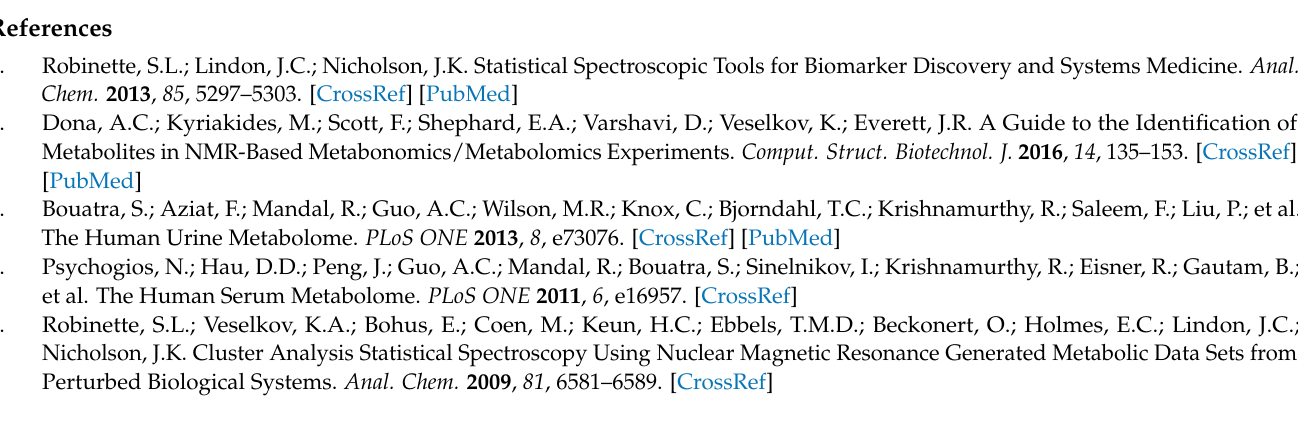
Figure S2: Salicyluric acid; Figure S3: Experimental details for sample preparation and acquisition of NMR spectra; Table S1: Table with metabolite